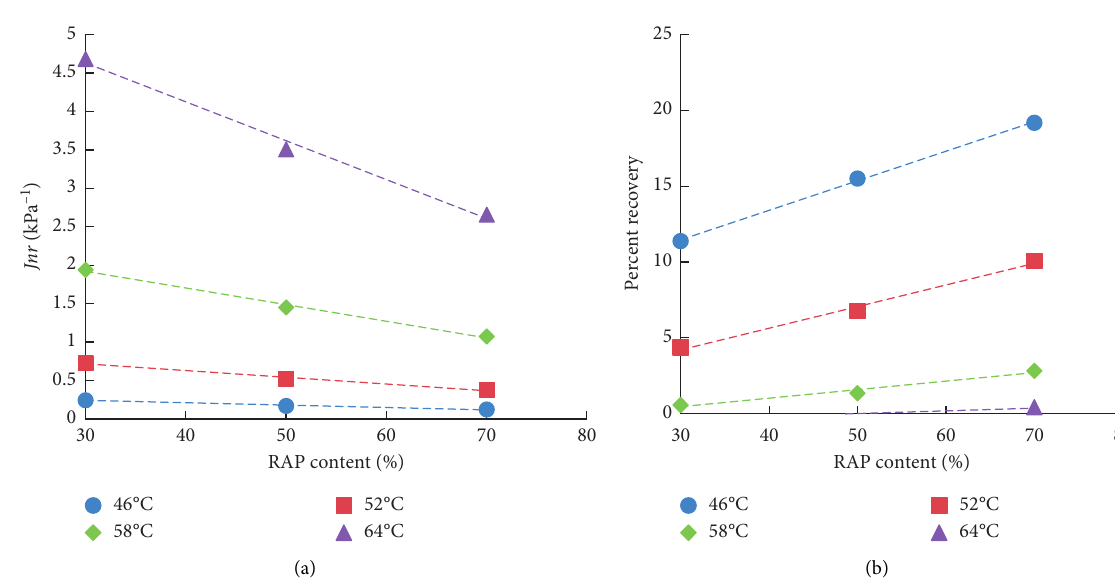
nr (k/Pa) and (b) R (%).